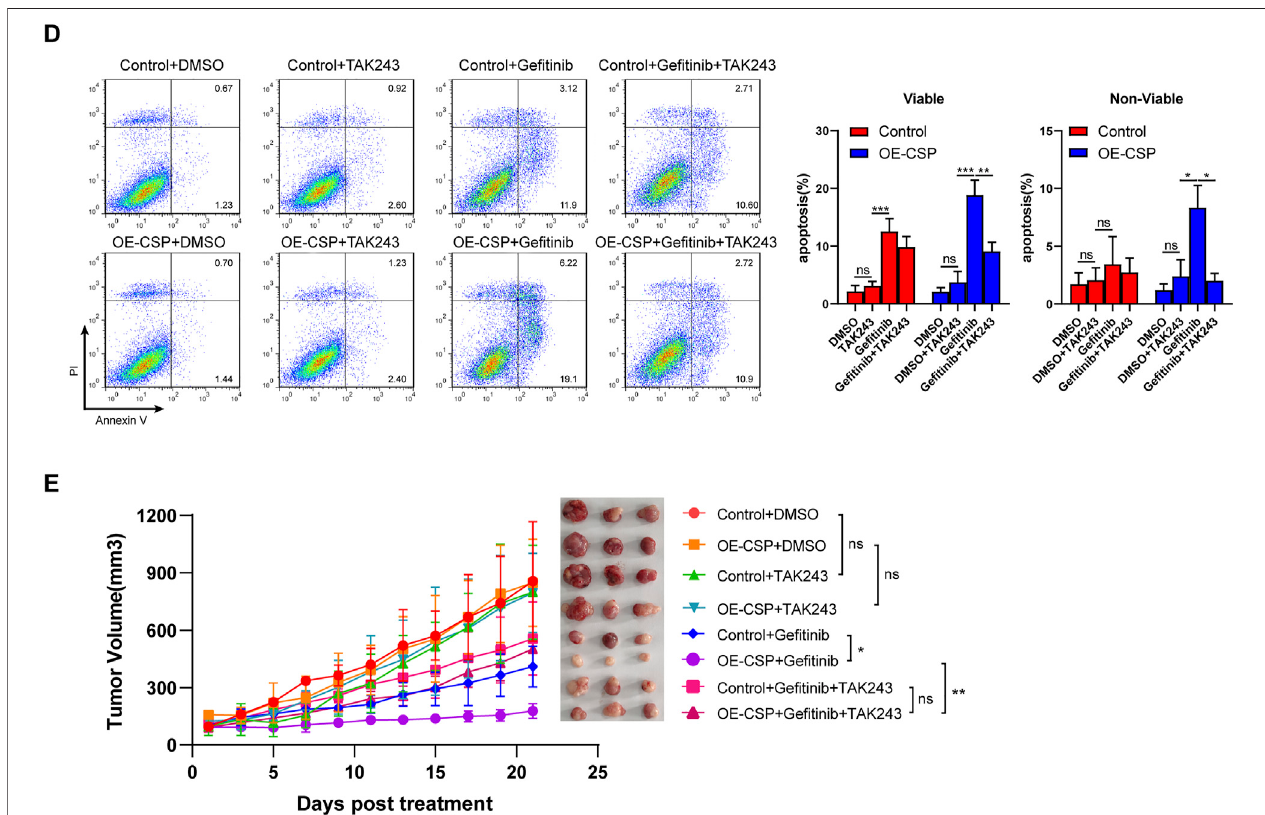
FIGURE 7 | Ubiquitin inhibition by TAK-243 rescues the sensitizing effect of CSP on ge fi tinib. (A) Control and OE-CSP A549 cells (1 × 10 6 ) were transfected with GFP-LC3B plasmid and then treated with TAK-243 and MG132 for 24 h. The GFP-LC3B was puri fi ed and the level of ubiquitin was detected by Western blotting. Cell viability after treatment with TAK-243 and ge fi tinib was examined by (B) a CCK8 kit ( left ) and LDH assay ( right ). (C) Cell colony formation ability and (D) apoptosis were also assessed using the method described above. The clone rate (%) was normalized to the control group (DMSO). Representative images for colony analysis and fl ow cytometry ( left ) and statistical histograms ( right ). Viable, early apoptotic cells; non-viable, late apoptotic cells. (E) Nude mice were then treated with TAK-243 plus ge fi tinibwhenthetumorvolumewasapproaching100 mm 3 .Experimentswererepeatedtwotimeswiththreemicepergroupperexperiment.Thedataarepresentedas the mean ± standard deviation of three independent experiments in vitro (ns, not statistically signi fi cant, ** p < 0.01, *** p < 0.001).